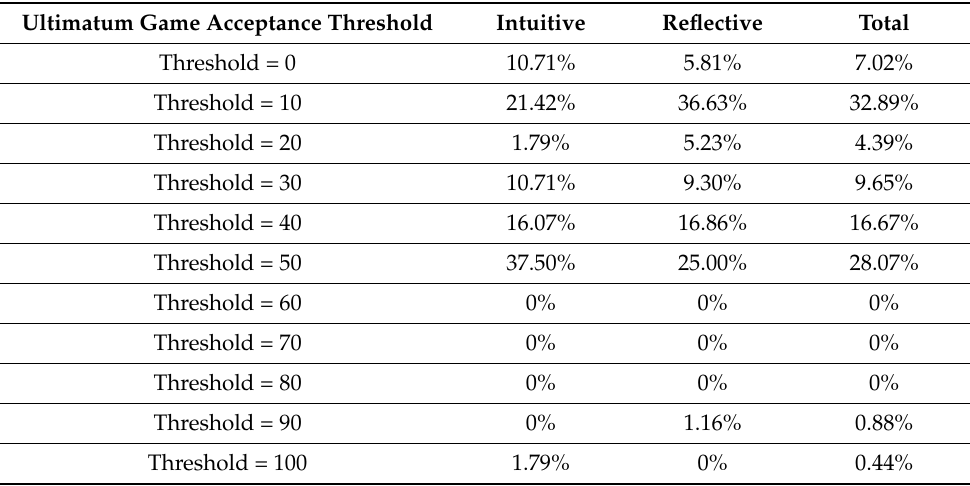
Table A3. Frequency of Ultimatum Game Acceptance Threshold by Intuitive (Reflective) Individuals. Ultimatum Game Acceptance Threshold